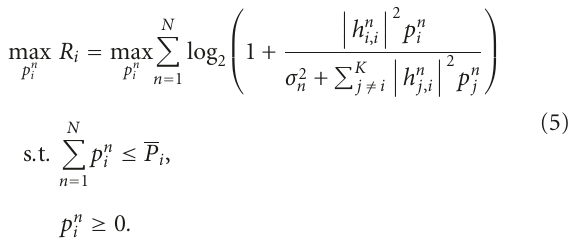
is characterized by its received noise power on each carrier n , by σ 2 n